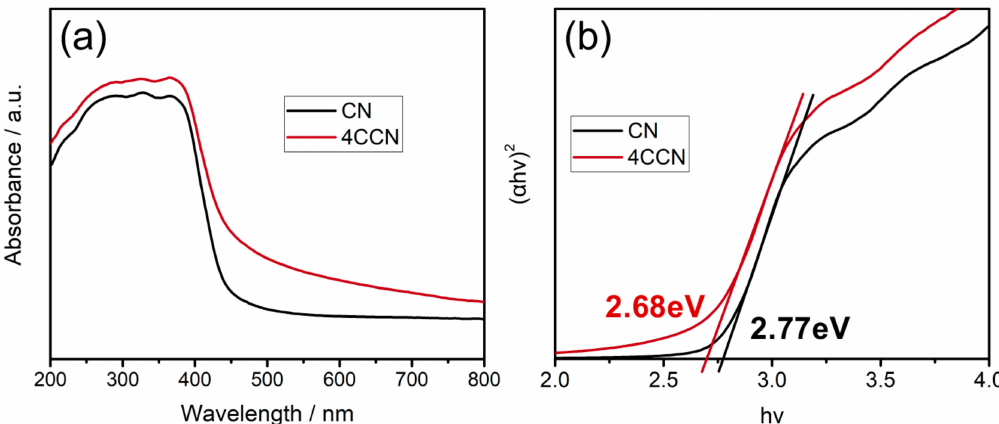
Figure 5. UV-Vis absorption spectra ( a ) and Tauc plot ( b ) of CN and CCN